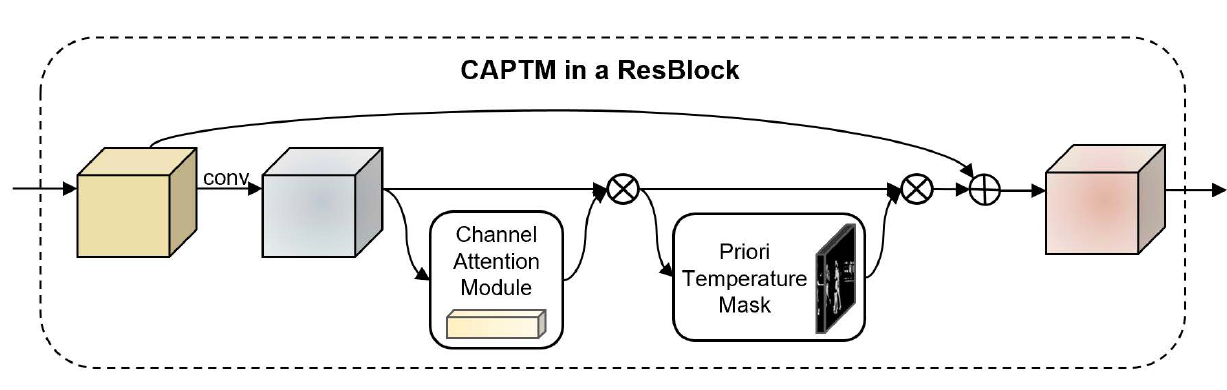
Figure 5. Embedding the CAPTM module into the residual block in ResNet [12] .